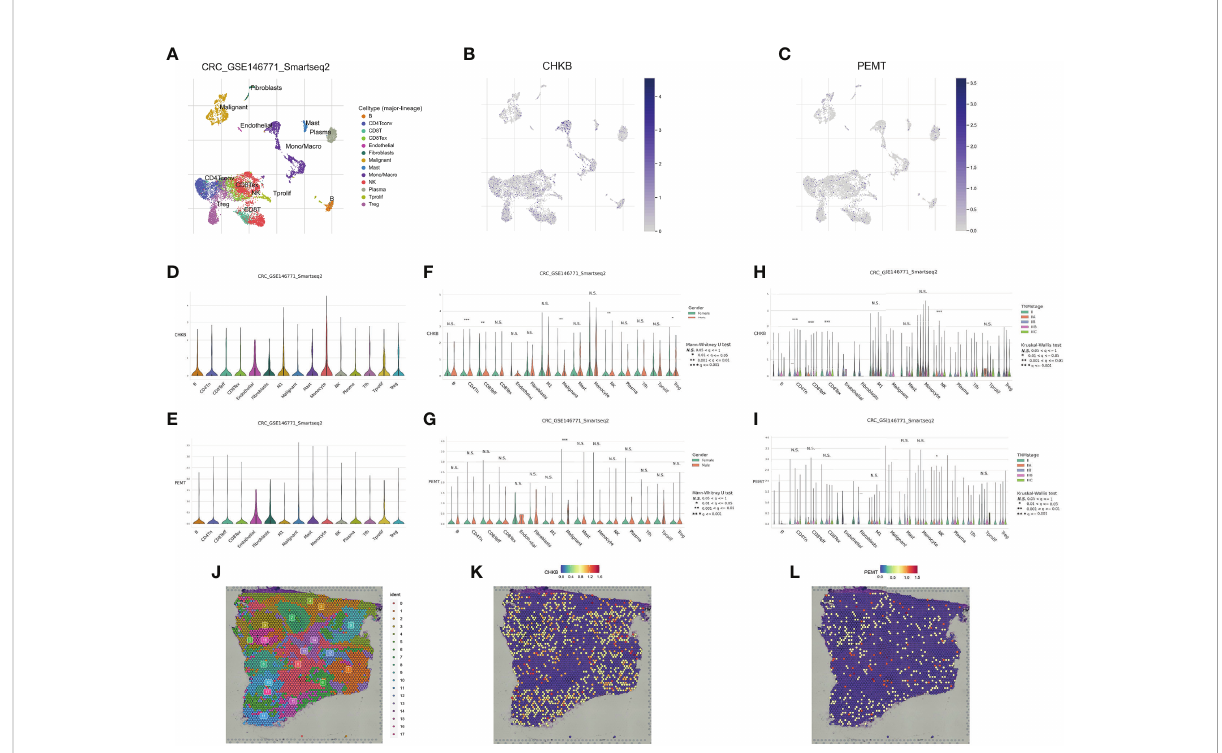
FIGURE 8 Correlation of the choline metabolism-related signature with single-cell properties. (A) UMAP plot of thirteen major cell clusters in the COAD tumor microenvironment. (B, C) The distribution of CHKB (B) and PEMT (C) in cell subsets. (D, E) Violin plot of CHKB (D) and PEMT (E) expression at the single- cell level. (F, G) Expression of CHKB (F) and PEMT (G) at the single-cell level after strati fi cation based on gender. (H, I) Expression of CHKB (H) and PEMT (I) at the single-cell level after stage-based strati fi cation. (J) HE-stained images of COAD tissue sections labeled with seventeen cell clusters. (K) Spatial expression levels of CHKB in COAD tissue sections. (L) Spatial expression levels of PEMT in COAD tissue